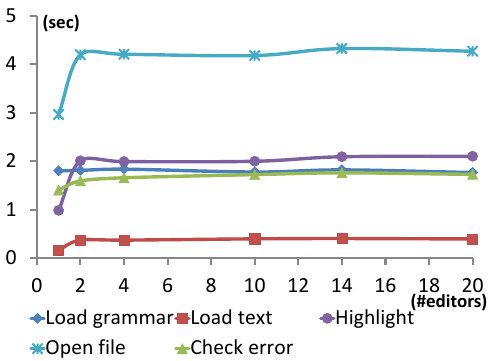
Figure 10. Effect of varying the number of concurrent editors, written in the